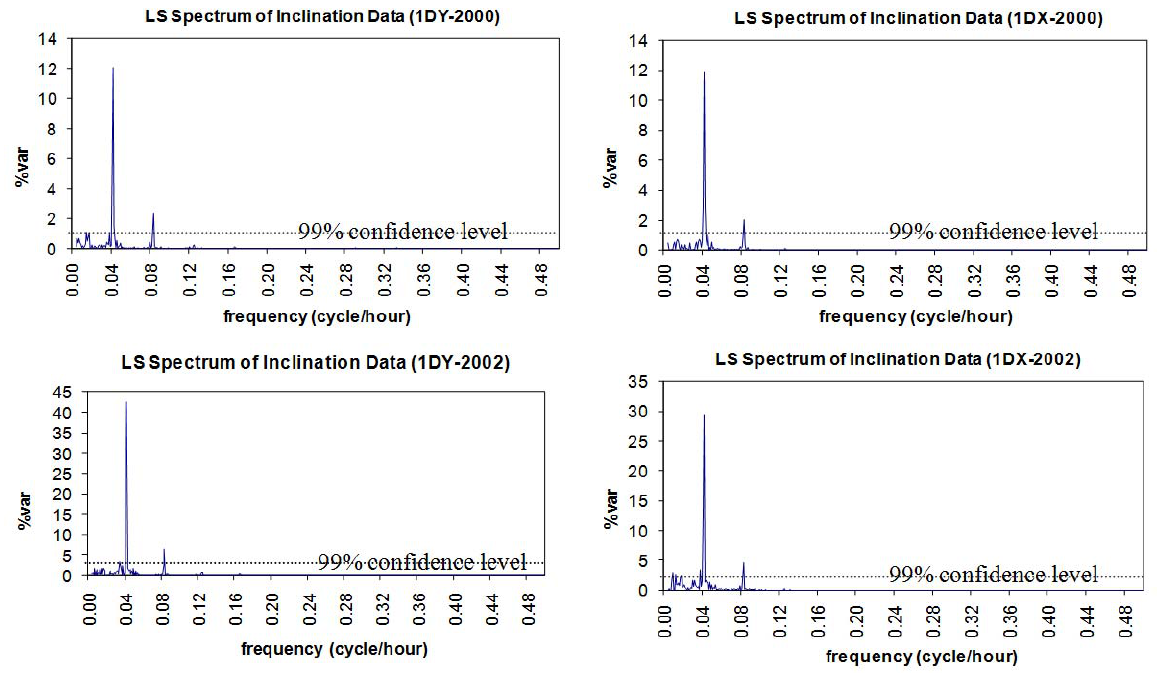
Figure 12. LS spectrum of inclination data of Sensor I mounted on the building that hosts the pillar. Campaign 2000-Y axis (1DY-2000) and X axis (1DX-2000). Campaign 2002-Y axis (1DY-2002) and X axis (1DX-2002).